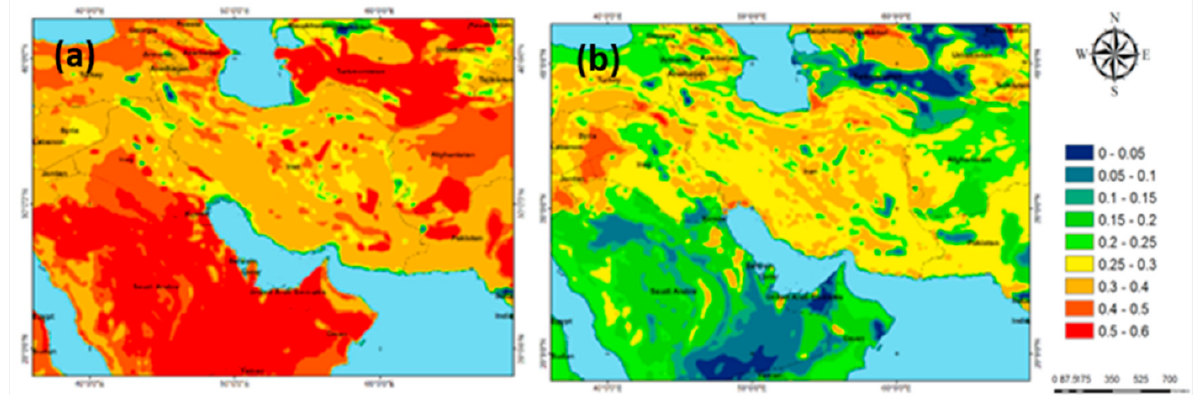
Figure 6. Sand fraction ( a ) and clay fraction ( b ) used in the dust emission scheme in the WRF